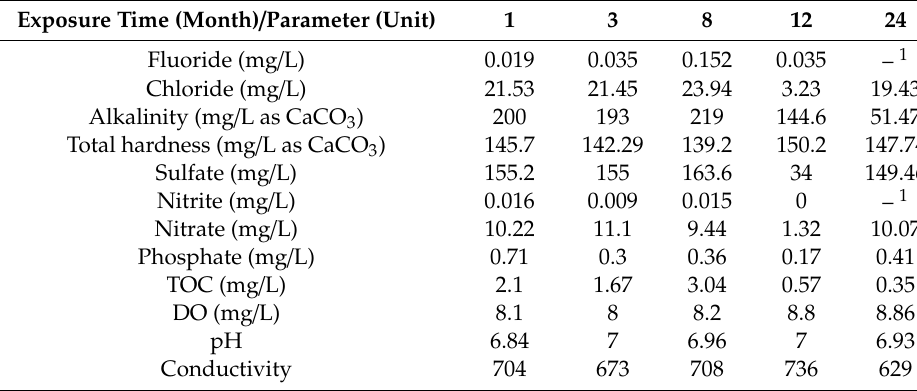
Table 2. Physicochemical properties of the source